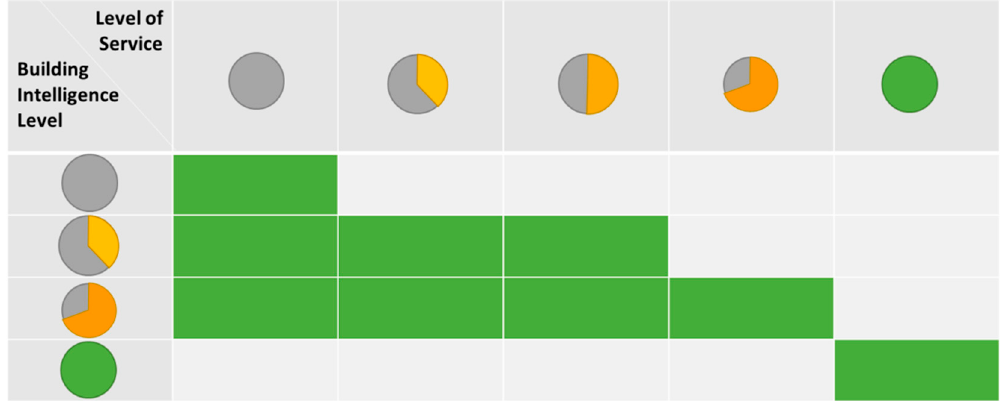
Figure 1. UtilitEE combination of Level of Services & Building Intelligence